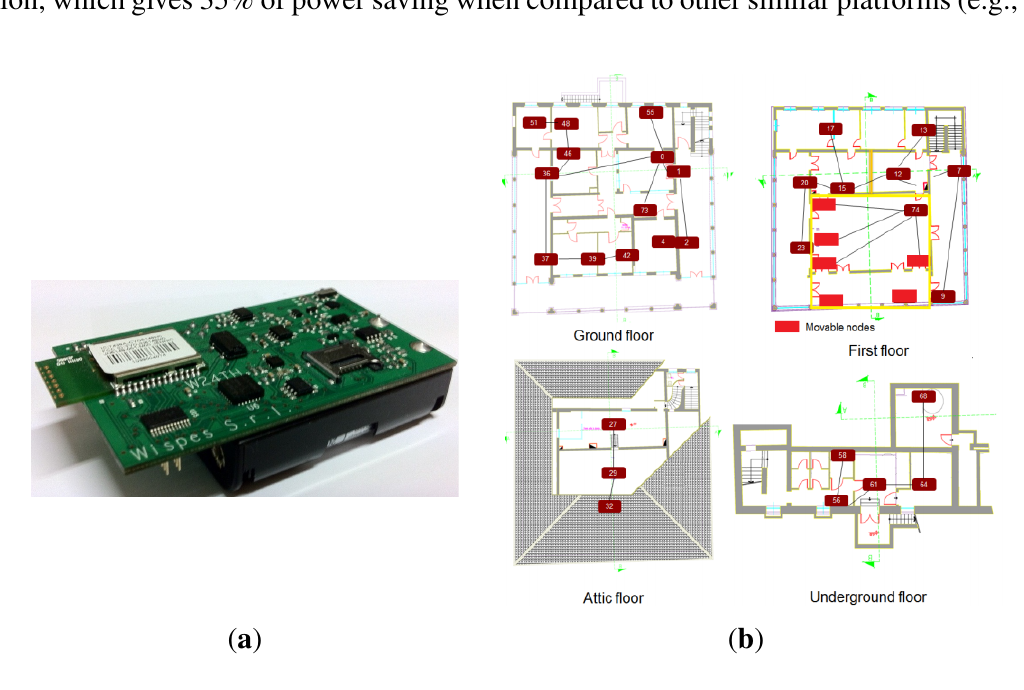
Figure 2. ( a ) The W24TH sensor node and ( b ) the deployment